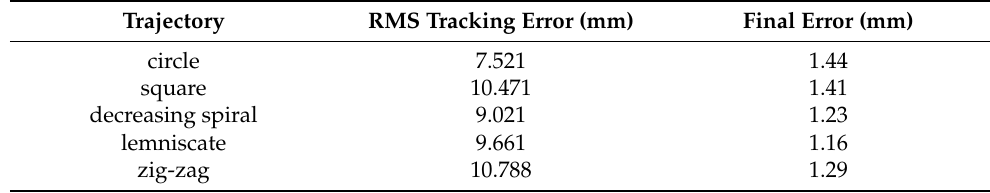
Table 3. Tracking and final positioning errors for freehand moving target along different